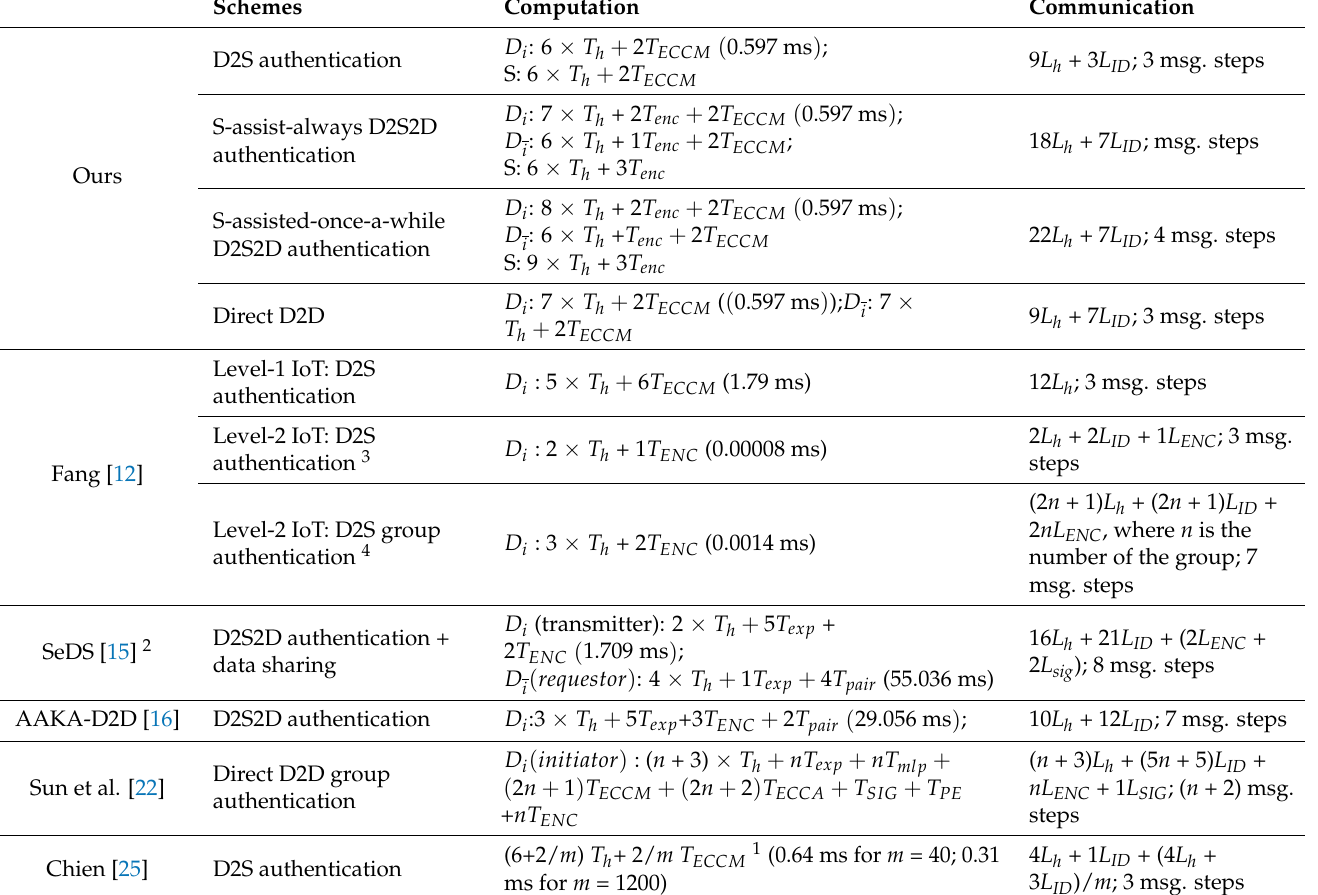
Table 4. Summary of the computational cost and the communication cost per